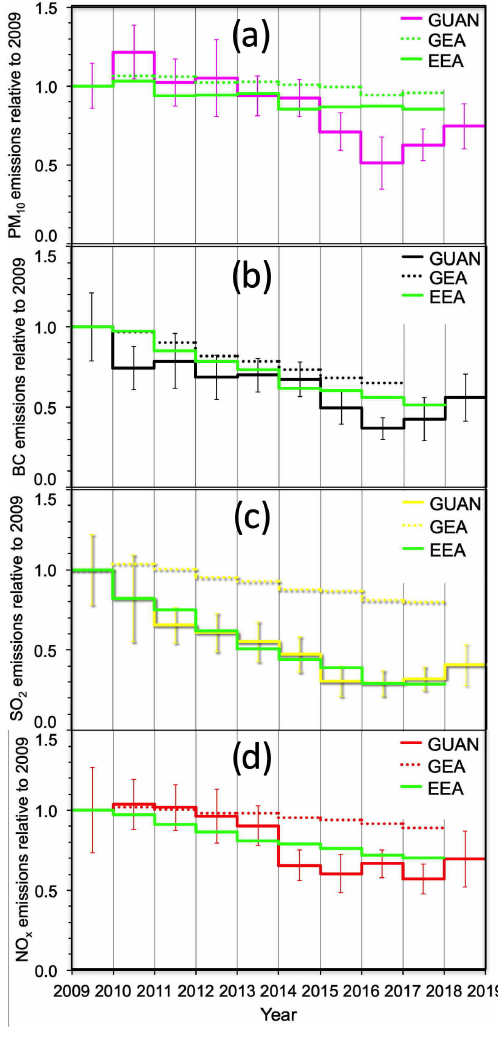
Figure 6. GUAN: trends in the emissions of (a) PM 10 , (b) BC, (c) SO 2 , and (d) NO x relative to 2009 as calculated by optimizing the agreement between 2009 EDGAR emissions and concentrations measured at the four stations in the present study. The error bars represent annual average relative deviations between measured and simulated data. GEA: trends as reported for Germany by the Ger- man Environment Agency. EEA: trends as optimized from combi- nations of trends over Germany and neighboring countries (see the text for